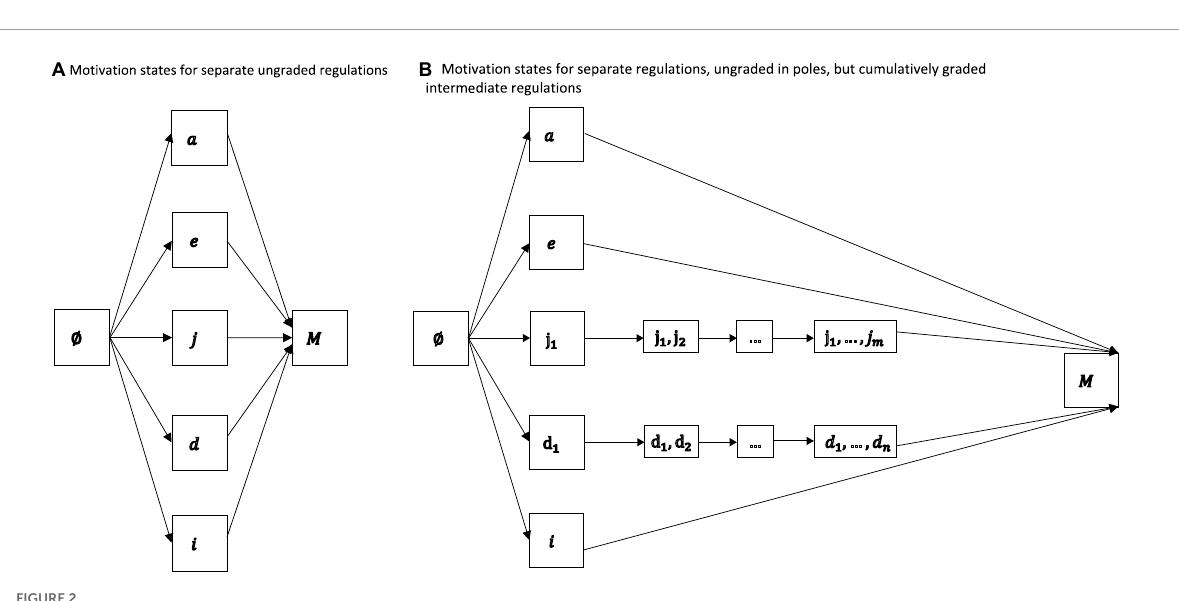
FIGURE2 Motivation states for separate ungraded regulations (A) and separate but cumulatively graded intermediate regulations (B) . In both representations, non-regulation, external regulation, and intrinsic regulation are singletons. The linear orders imposed on the gradations of introjected regulation and identified regulation could be associated with the varying cumulative internalities that the gradations may have along an internalization